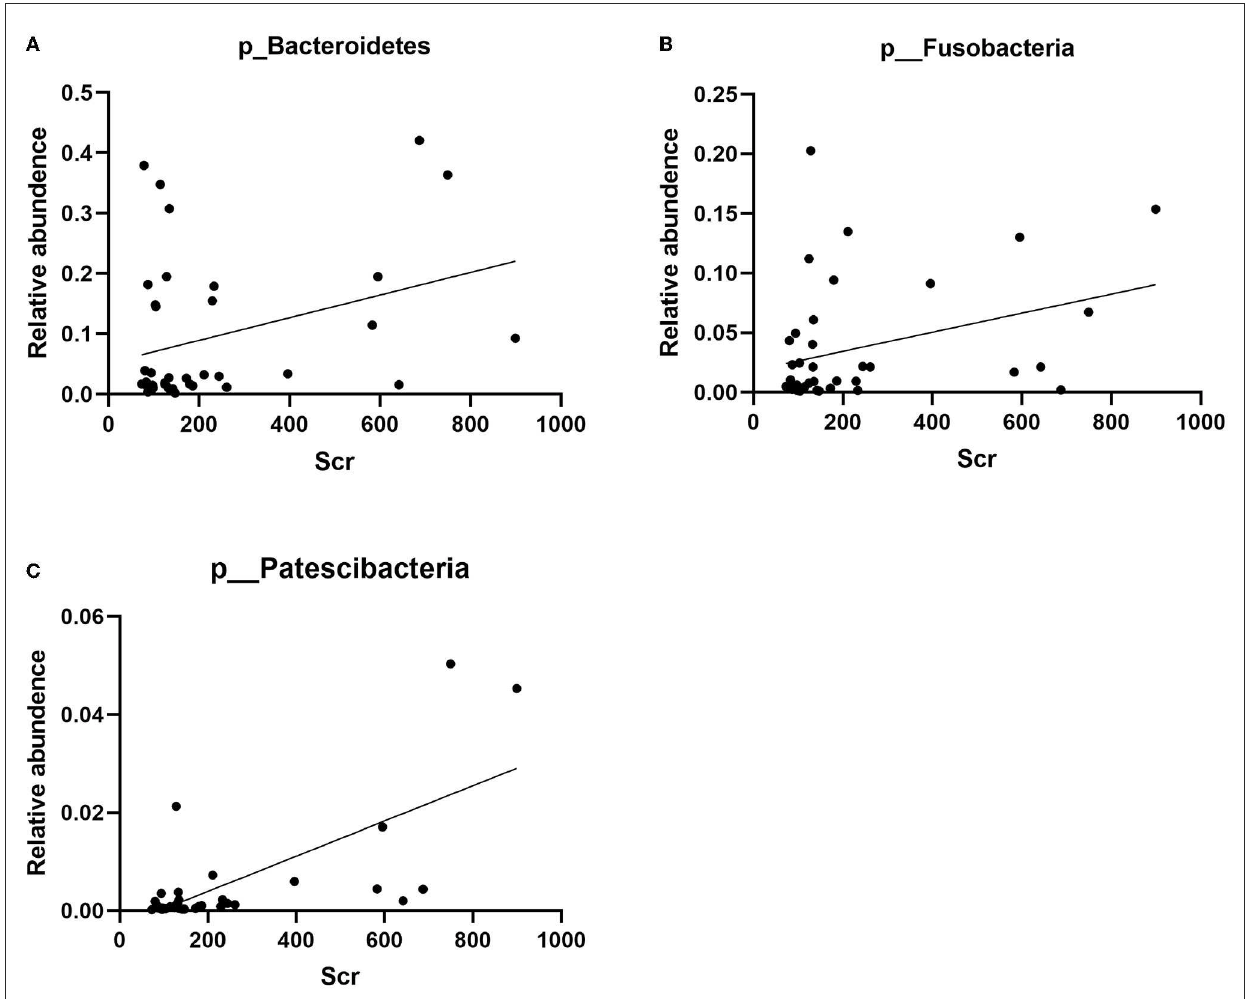
FIGURE4 Correlation between Bacteroidetes, Fusobacteria, Patescibacteria, and Scr: (A) the scatter diagram of relative abundance of Bacteroidetes and Scr concentration; (B) the scatter diagram of relative abundance of Fusobacteria and Scr concentration; (C) the scatter diagram of relative abundance of Patescibacteria and Scr